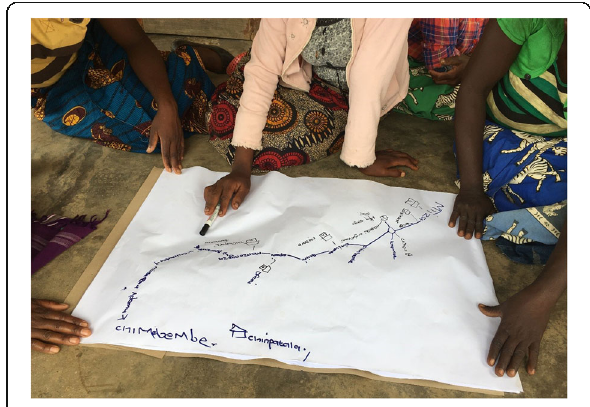
Fig. 1 Participatory GIS/map drawing, Malawi 2017. Photo: Stine H Braathen, SINTEF